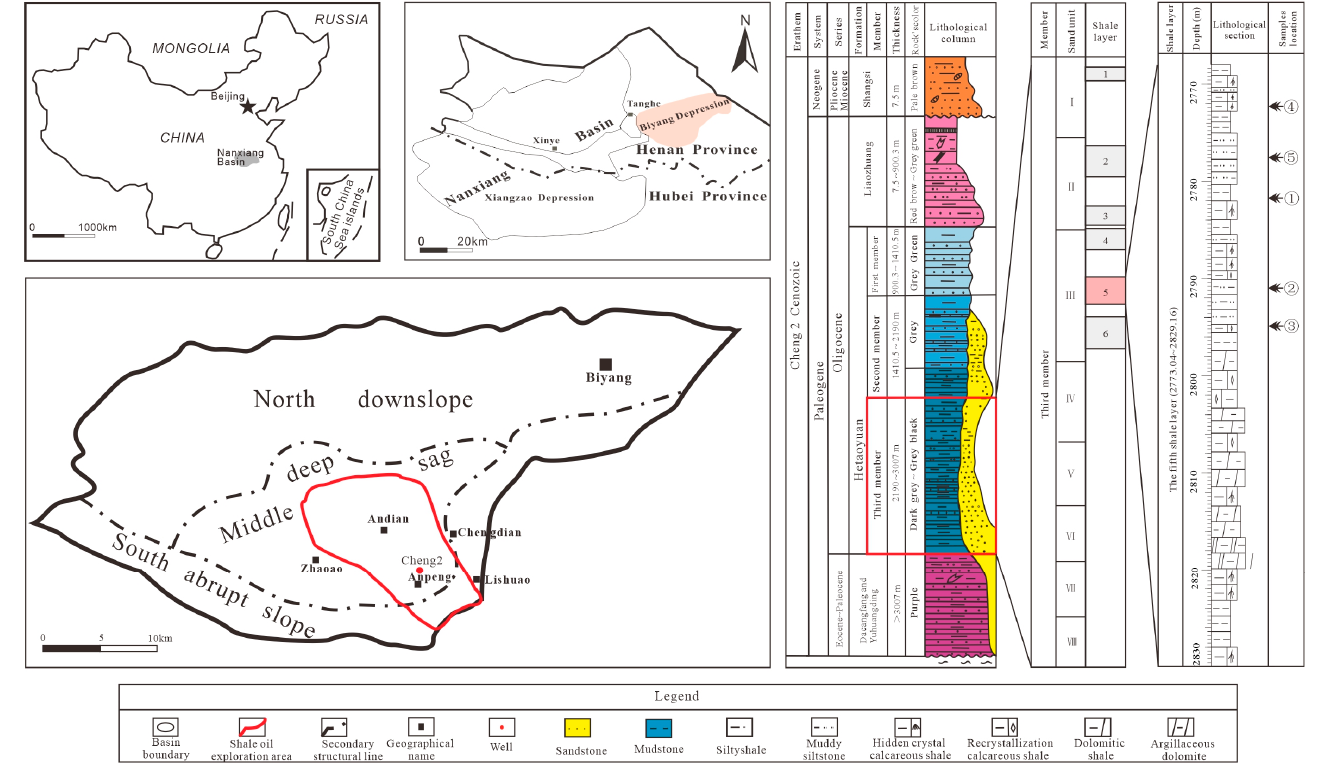
Figure 1. Location and generalized stratigraphic columns of the Biyang Depression and sample locations (Adapted with permission from Ref. [5]. 2016, Elsevier, adapted with permission from Ref. [33]. 2019, Elsevier).